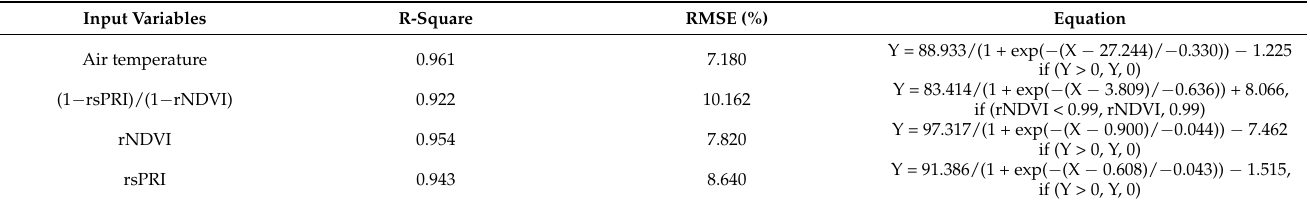
Table 2. Statistical results of the estimation of ripening ratio using air temperature and relative vegetation